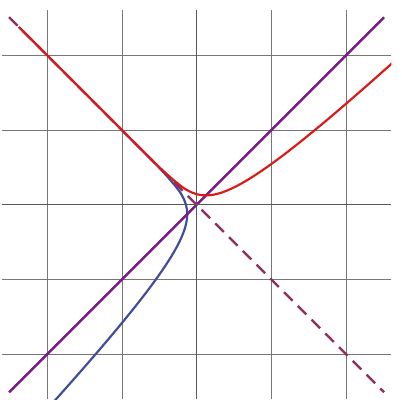
Figure 20: Spacelike ( blue ) and timelike ( red ) curves in (cid:2) 2 with (cid:2) ( ) = v ϵe − v − , = ± ϵ 1 .